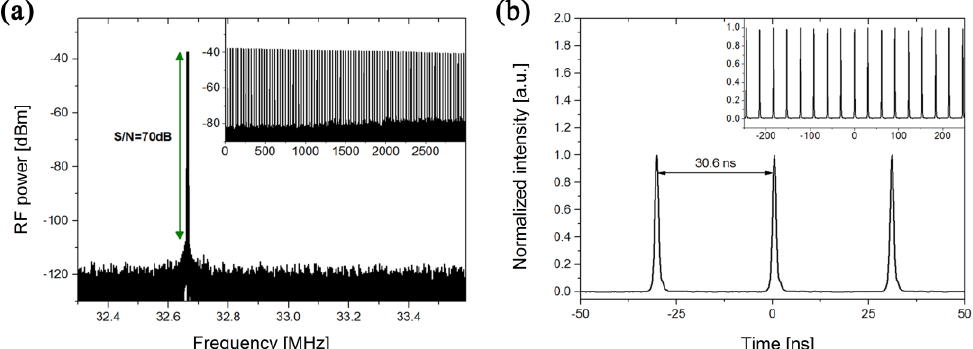
Figure 9. The RF spectrum ( a ) measured in the 1.3 MHz span with 80 Hz resolution bandwidth (RBW) presenting the repetition frequency of the laser and the S/N ratio—in the inset is the broad range of harmonics without spectral modulations measured in the 3 GHz span with 47 kHz RBW. The oscilloscope trace ( b ) presenting the train of pulses separated of 30.6 ns—in the inset is the broad range of pulses confirming stable operation and very low fluctuations of pulse amplitudes.